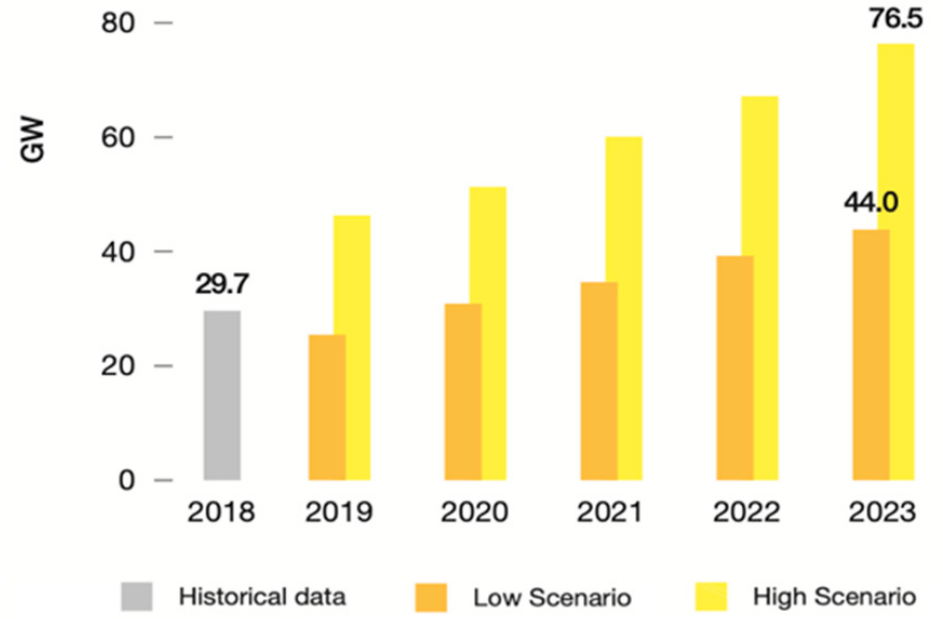
Figure 1. PV installation estimates on the rooftop until 2023 [1].